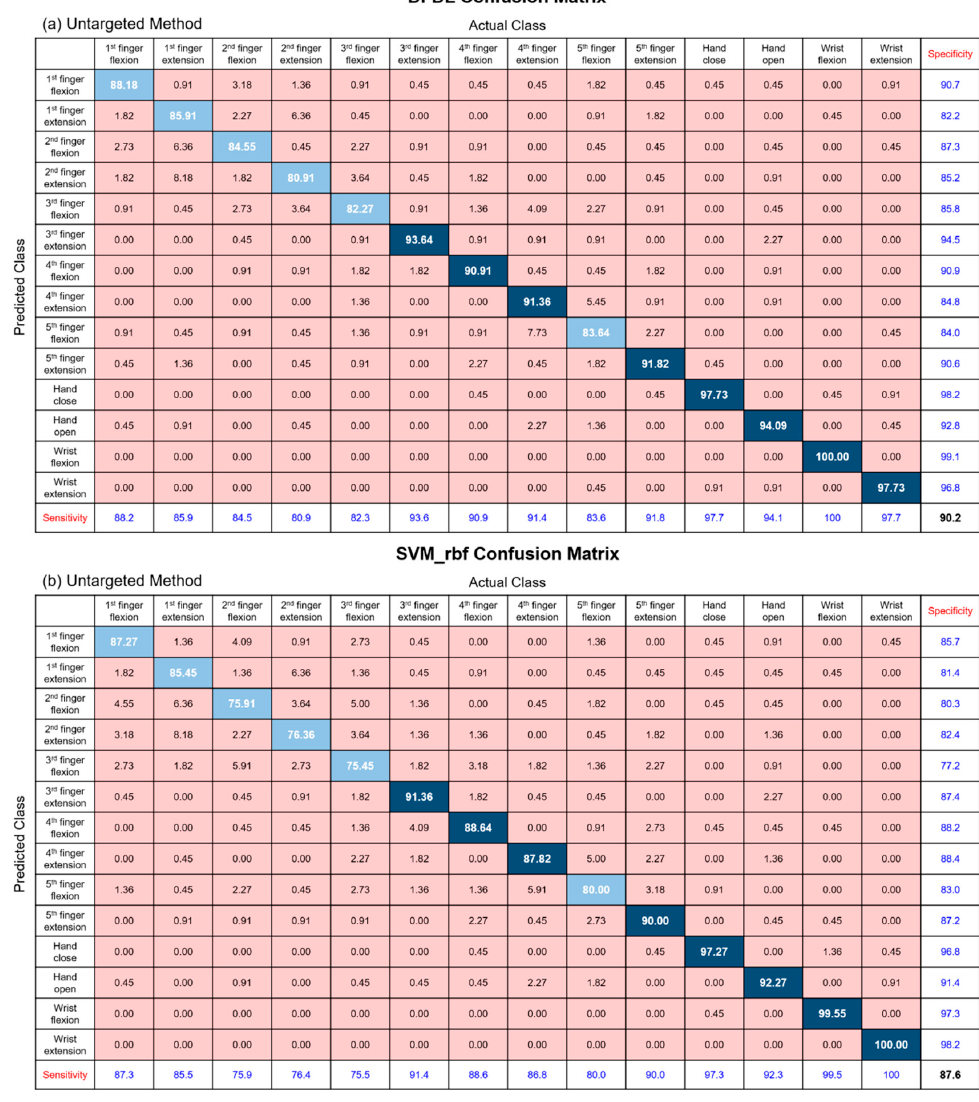
Figure 7. The classification results of each class using the untargeted method represented by a confusion matrix. ( a ) DFDL with the untargeted method. ( b ) SVM_rbf with the untargeted method. The diagonal elements represent the classification accuracy for which the predicted class is equal to the actual class, while the off-diagonal elements indicate those that are misclassified. Sensitivities and specificities for each class are calculated.